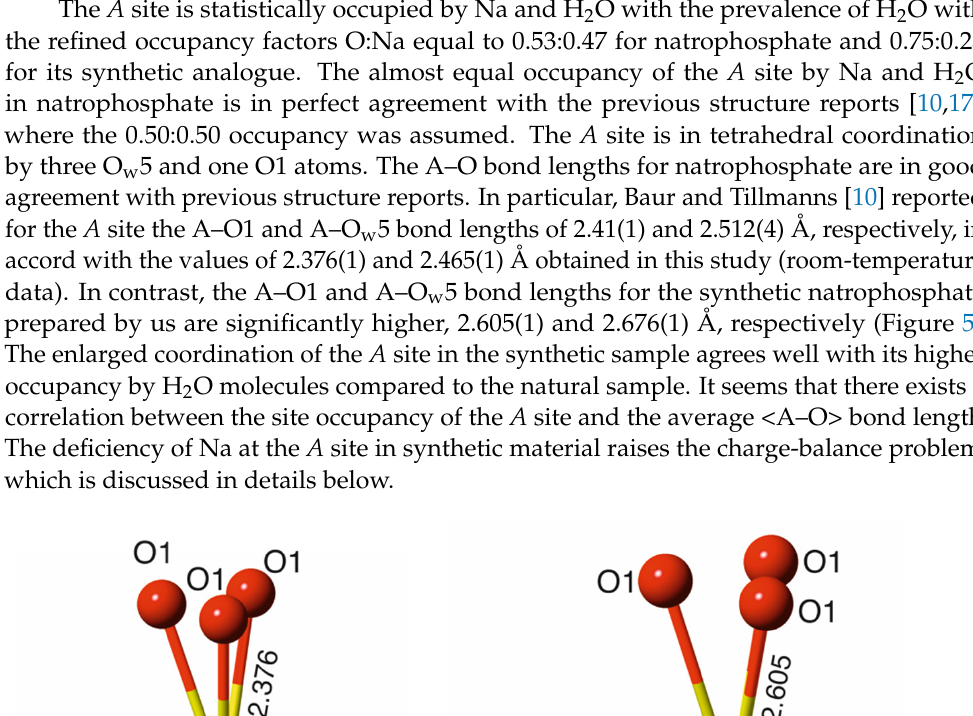
refinement. Table 4. Hydrogen atoms coordinates, occupancies (Occ) and displacement isotropic parameters (Å 2 ) for natrophosphate at 100 K. Atom